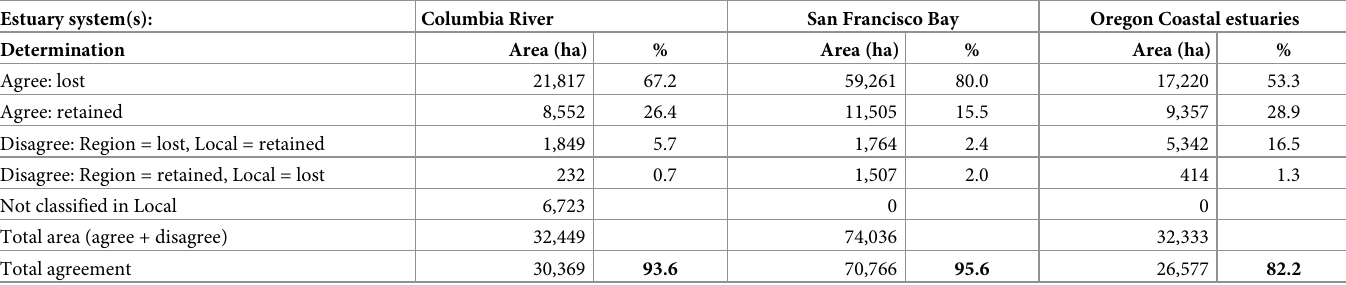
Table 6. Comparison between this project’s region-wide tidal wetland loss assessment (Region) and local assessment (Local) for the Lower Columbia River estuary [41], San Francisco Bay [42], and Oregon estuaries (http://www.coastalatlas.net/cmecs). Estuary